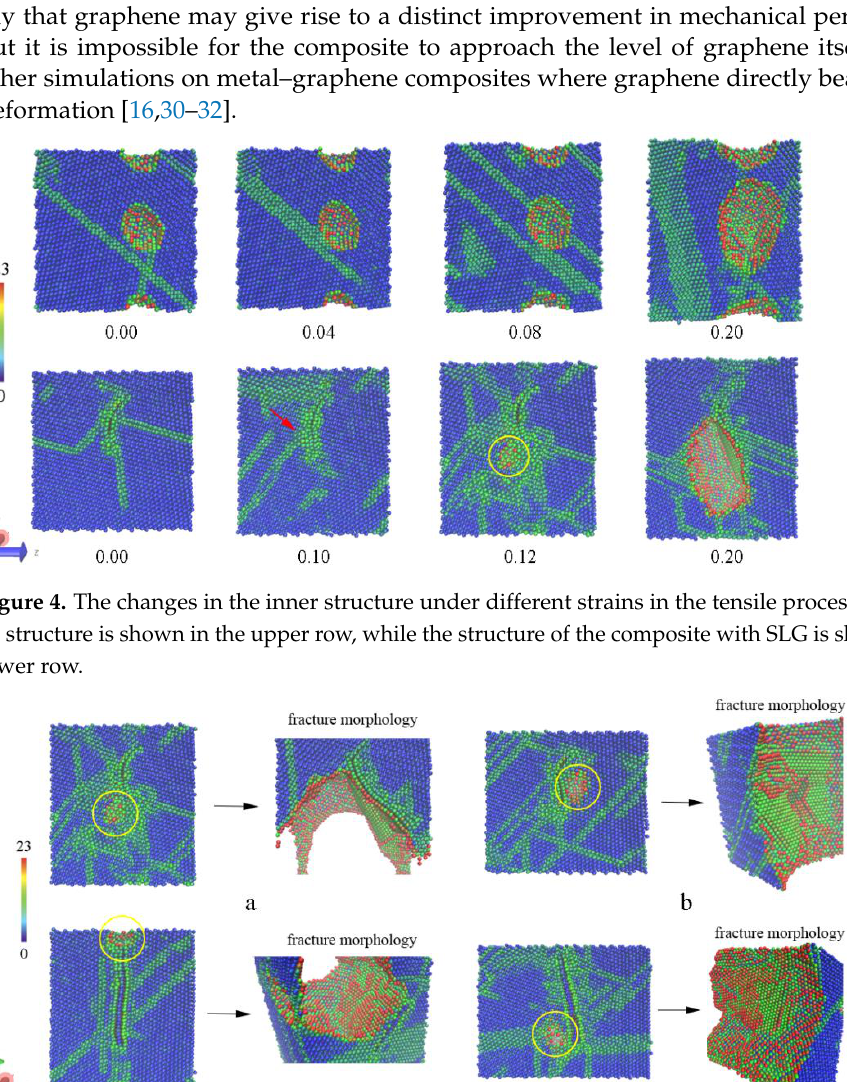
Figure 6. The atomic details of SLG in the tensile process. ( a ) SLG in sintered structure before stretch- ing; the stress distribution in SLG under maximum stress stretched in the y axis ( b ) and z axis ( c ). The networks on the left represent graphene, and the balls on the right represent adjacent Al atoms, which are colored by per-atom stress (unit: bar × Angstrom 3 ). The stress – strain curves of models stretched in in-plane and normal directions are drawn in Figure 7. It should be noted that the inverse Hall – Petch relationship will lead to a drop in strength at this scale where metal grains have a size of less than 10 nm. Distinctly, composites with both SLG and BLG exhibit a rise of about 1.2 GPa in tensile strength when stretched in in-plane direction, compared with the pure Al model. However, the Al – SLG